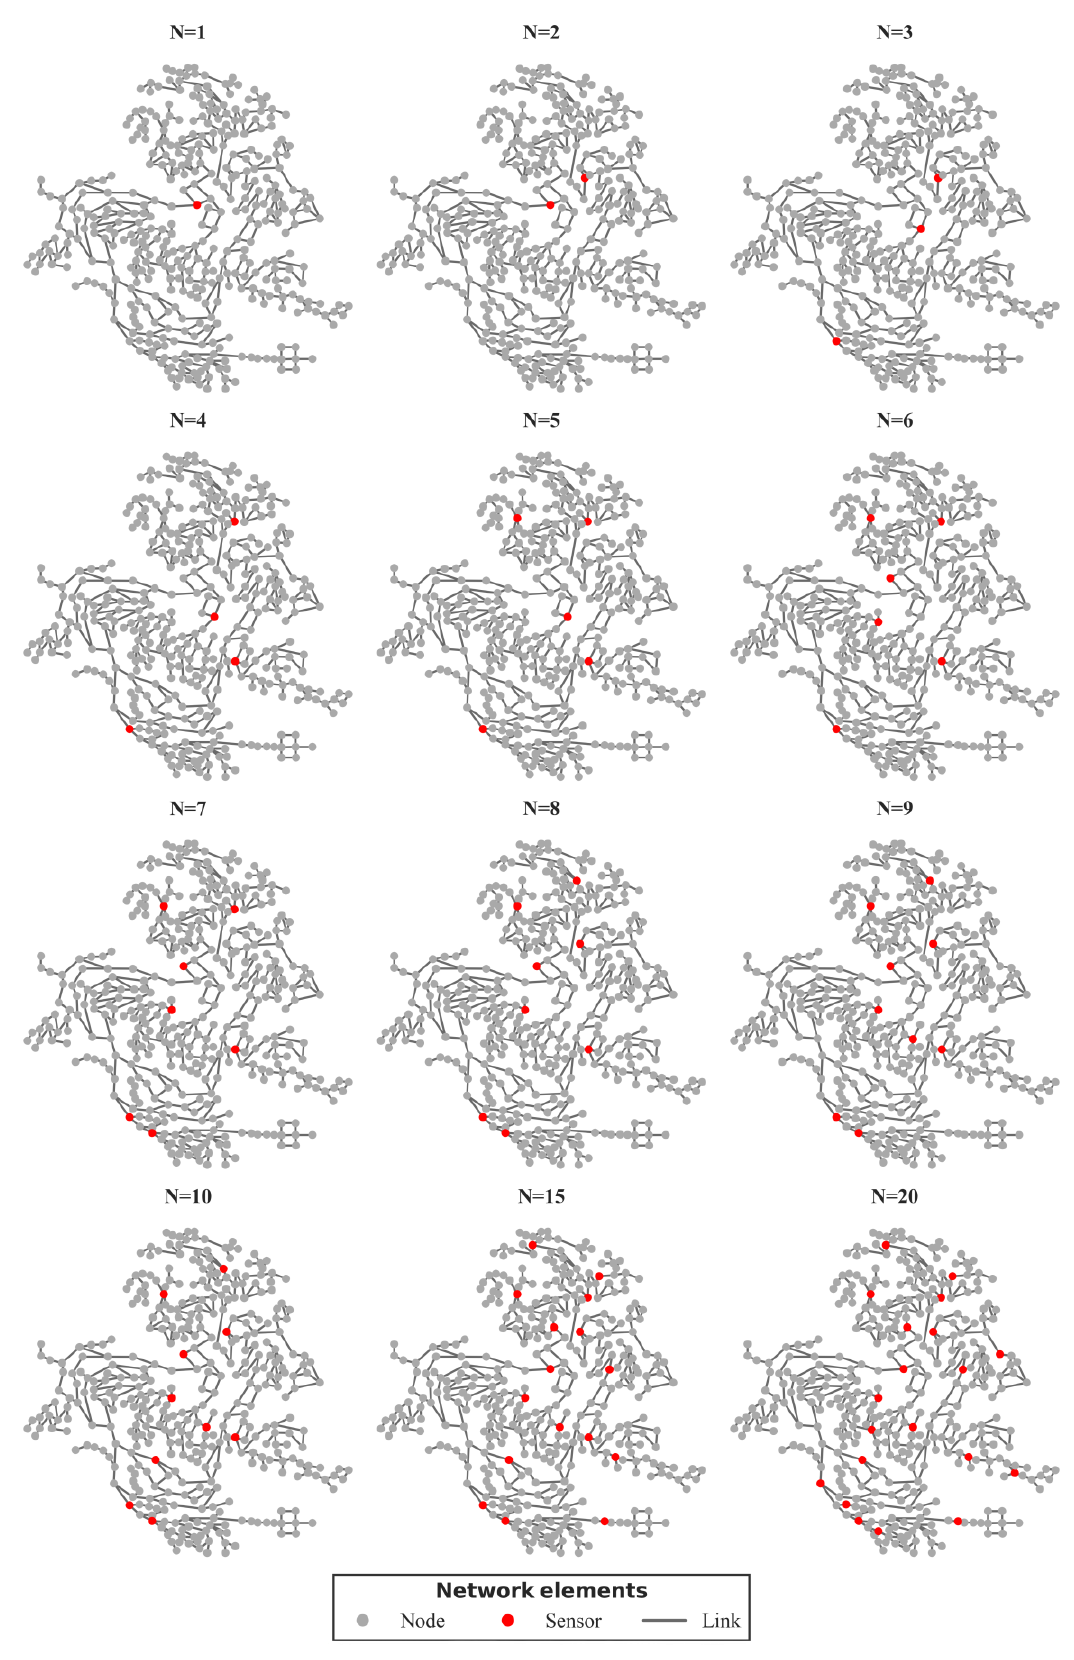
Figure 3. Sensor topologies generated by TEVA-SPOT for different numbers of sensors ( 𝑁 ).